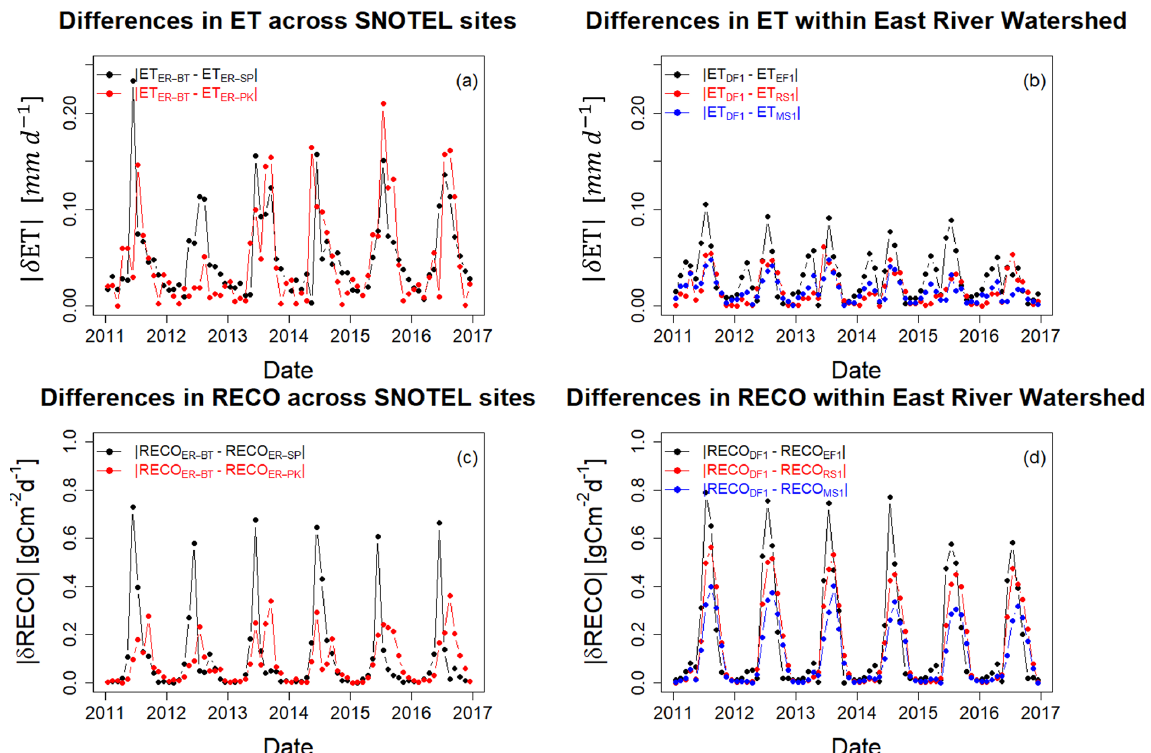
Figure 10. Absolute differences in monthly mean ET and R eco across SNOTEL stations and within East River Watershed. Panels (a) and (c) describe the absolute differences in monthly mean ET and R eco between ER-BT, ER-SP, and ER-PK. Panels (b) and (d) describe the absolute differences in monthly mean ET and R eco within East River Watershed between deciduous forests, evergreen forests, meadow grasslands, and riparian